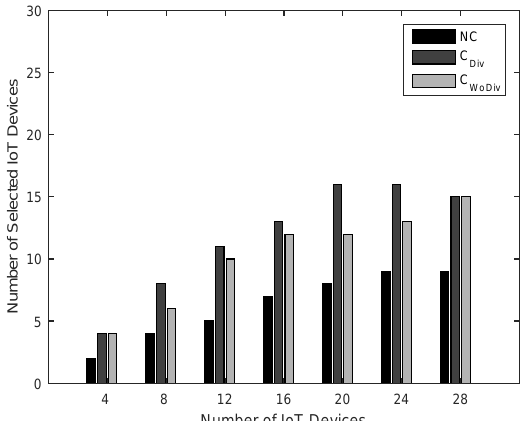
Figure 6. No. of admitted devices with respect to different number of total devices, with two relays and minimum device data rate of 1 Mbps.